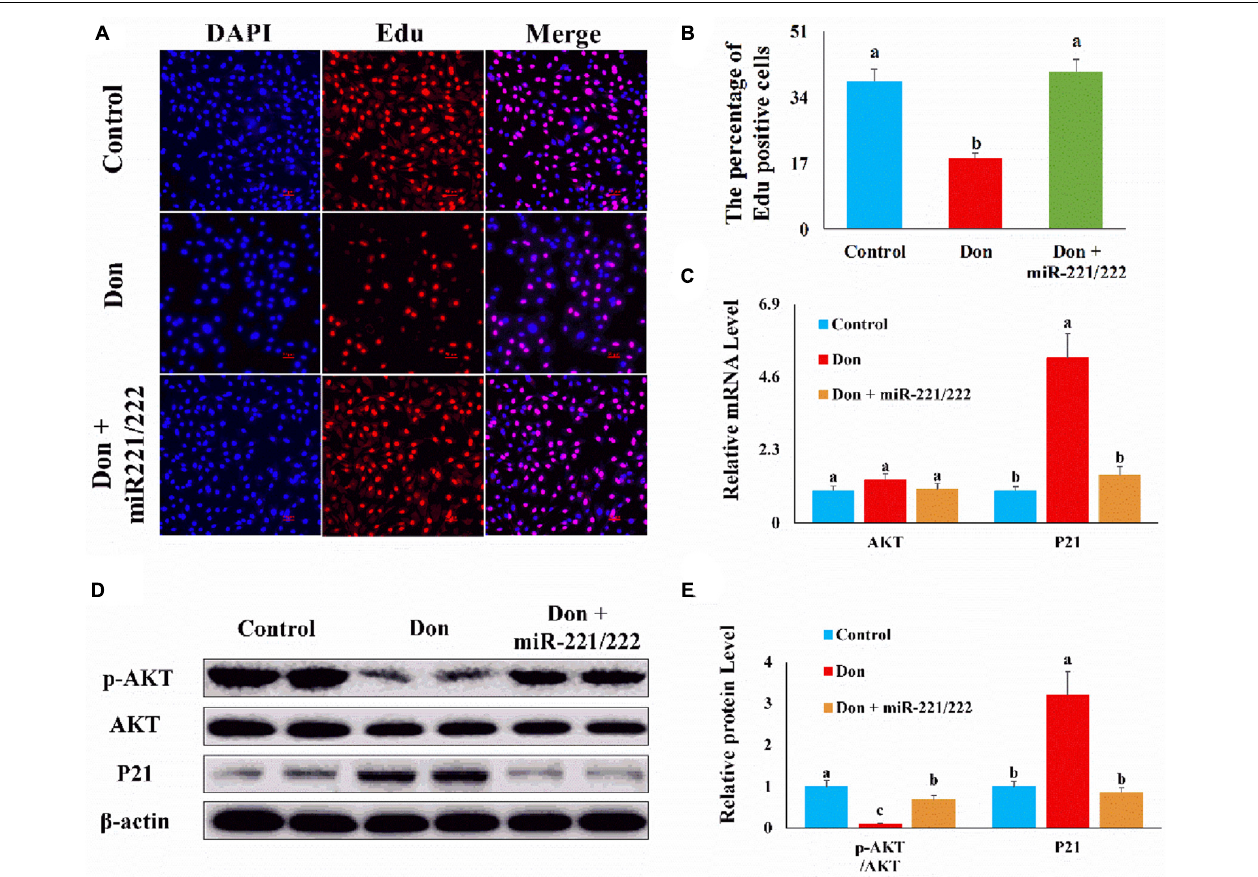
FIGURE 4 | MiR-221/222 reversed the inhibitory effect of Don on intestinal epithelial cell proliferation. (A) Representative images of the EdU staining for proliferating intestinal epithelial cells are shown. The cell nucleus was stained with DAPI, blue. Proliferating intestinal epithelial cells were labeled with EdU fluorescent dye (red). (B) The quantitative result of (A) . (C) qPCR results indicated that miR-221/222 reversed the inhibitory effect of Don on intestinal epithelial cell proliferation. (D) Western blot results showed miR-221/222 reversed the inhibitory effect of Don on intestinal epithelial cell proliferation. (E) The relative protein levels obtained by WB band gray scanning. Our results were presented as mean ± SEM of triplicate independent experiments for each group. Bars with different letters indicate they are significantly different ( p < 0.05). In (A) , magnification = × 100; the scale bar on the photomicrographs represents 100 µ m. Don, IPEC-J2 cells were exposed to 1.6 µ g/ml Don for 12 h. Don + miR-221/222, IPEC-J2 cells were transfected with 80 nM miR-221/222 mimics for 24 h, then exposed to 1.6 µ g/ml Don for 12